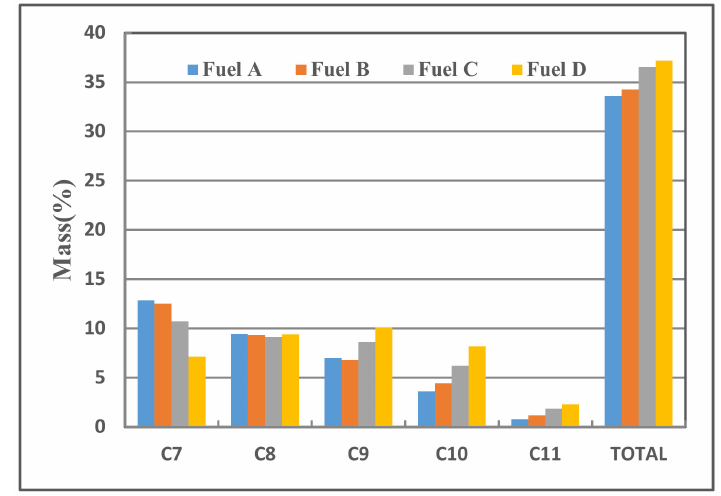
Figure 4. Aromatics content with different carbon numbers and total aromatic